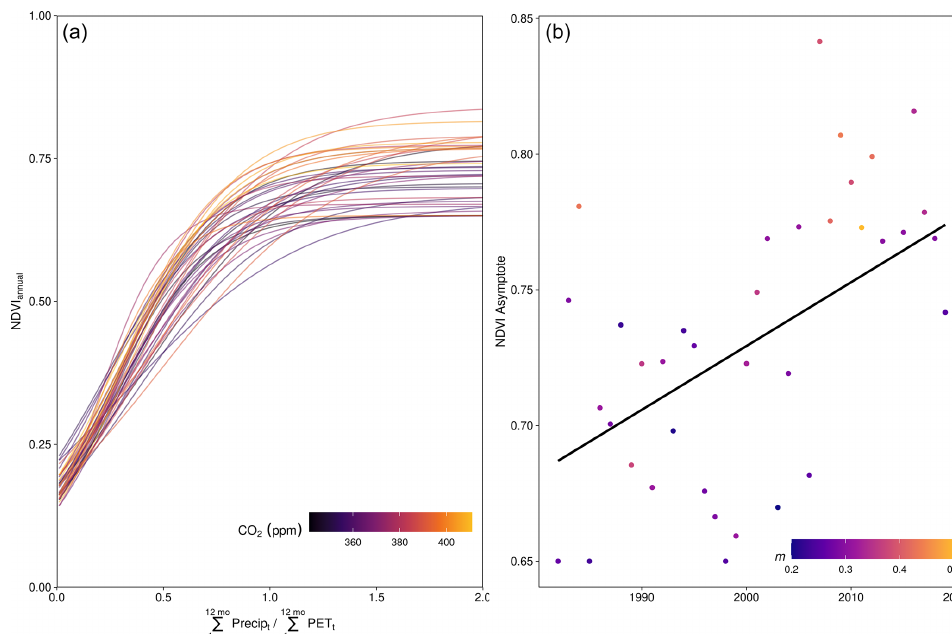
Figure A5. NDVI as a logistic function of annual P :PET. (a) Logistic function models, fit per hydrological year. (b) The positive long- term trend in the NDVI asymptote from the logistic model fits; m is the value of P :PET at the inflection point, and “NDVI Asymptote” corresponds to the V A parameter in Eq. (5).